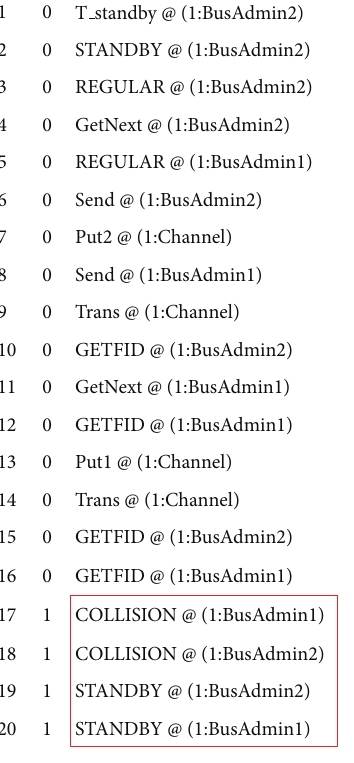
Figure 11: Simulation report for HCPN